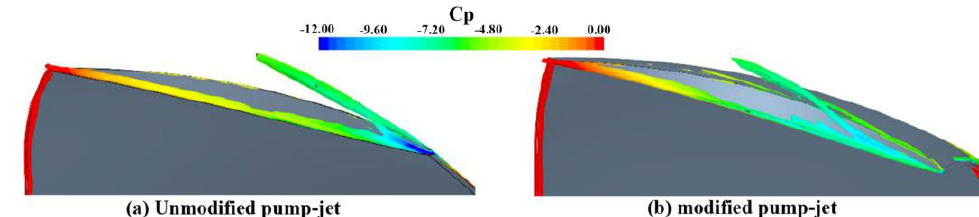
Figure 10. Comparison of separated vortex flow patterns [68]. ( a ) Unmodified pump-jet. ( b ) modi- fied pump-jet.